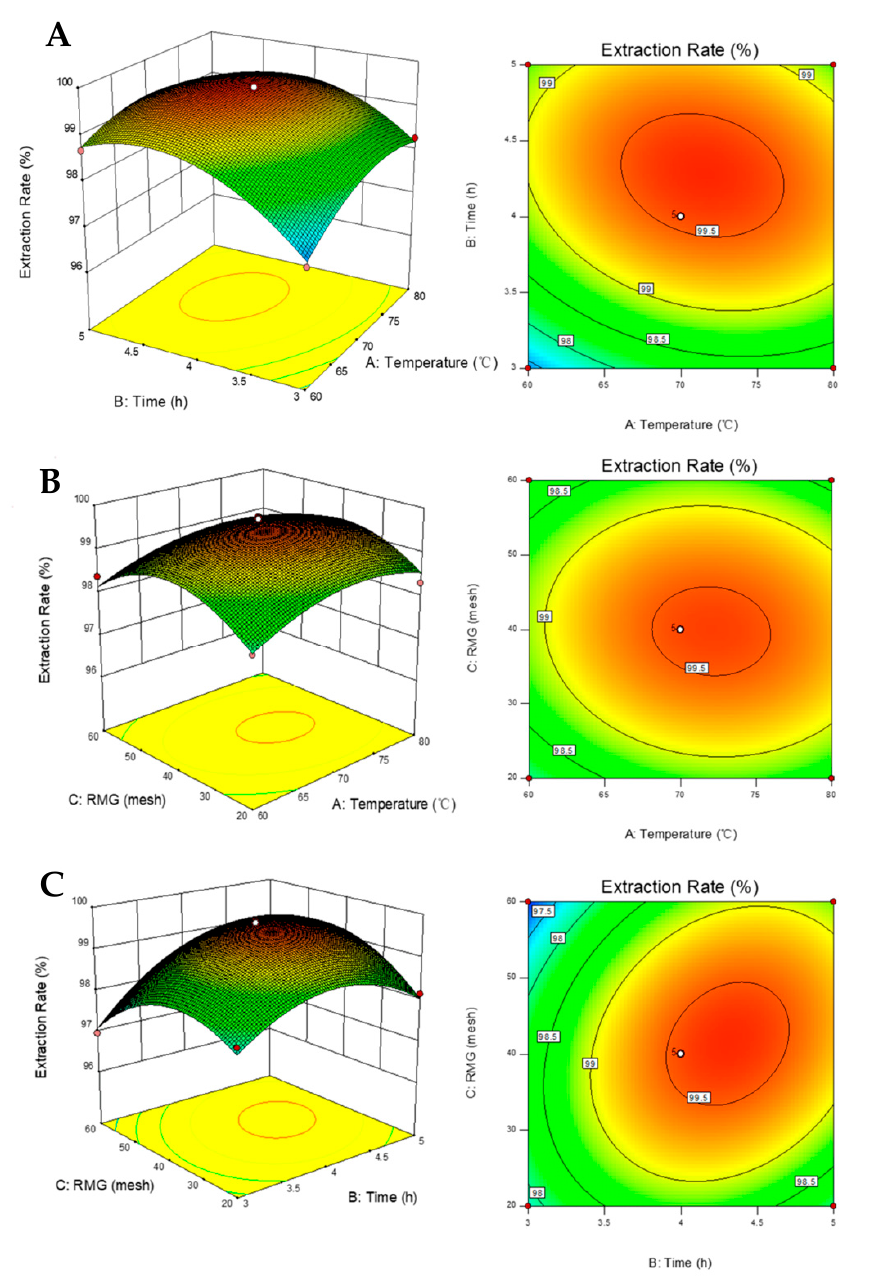
Figure 3. Three-dimensional response surface graphs and contour plots for the effects on naringin extraction rate under the following parameters: ( A ) temperature and time; ( B ) RMG and temperature; and ( C ) time and RGM.